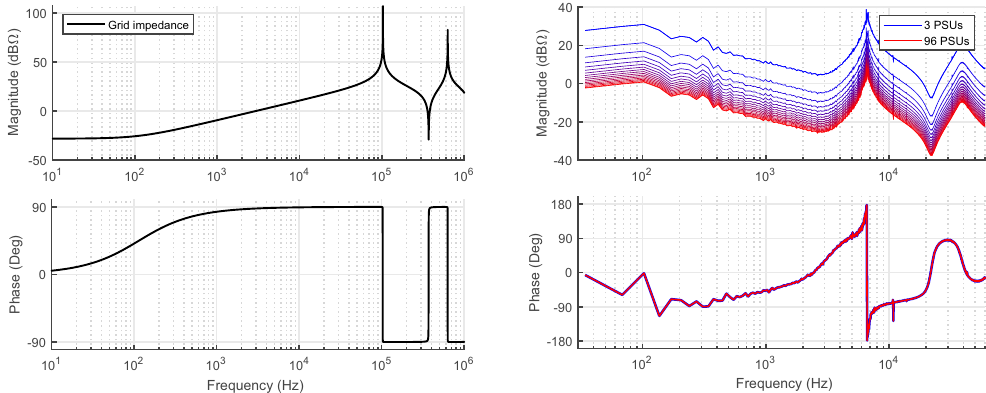
Figure 11. Modeled grid impedance (left, black) and aggregated measured PSU impedance (left, blue to red).